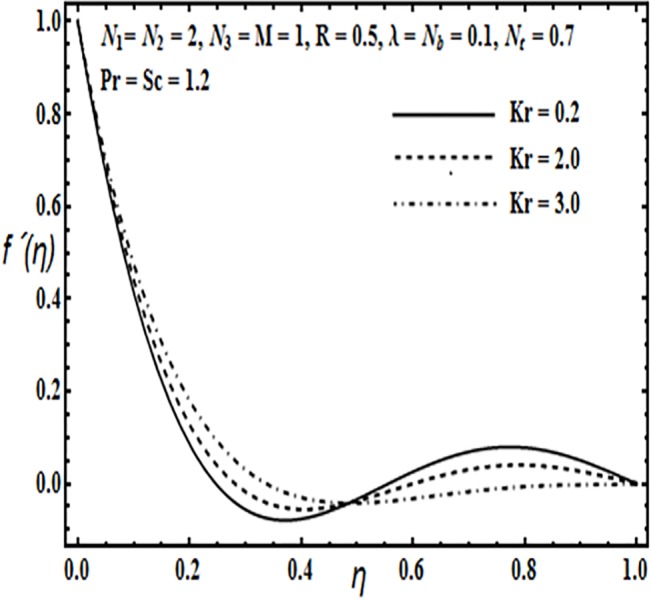
Effect of Kr on f′(η).